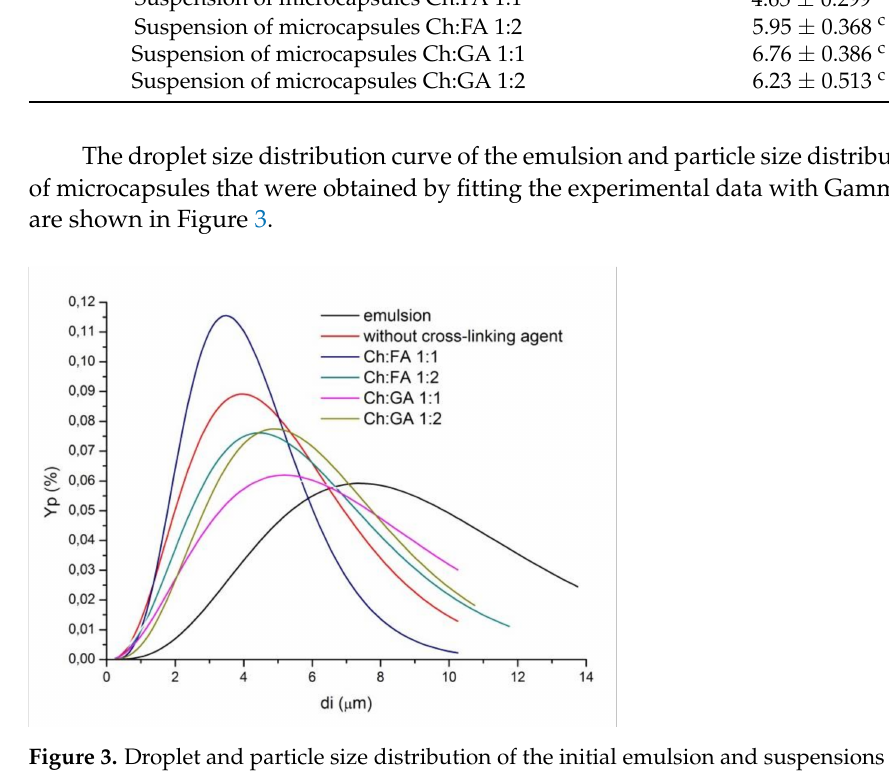
Figure 3. Droplet and particle size distribution of the initial emulsion and suspensions of microcap- sules,